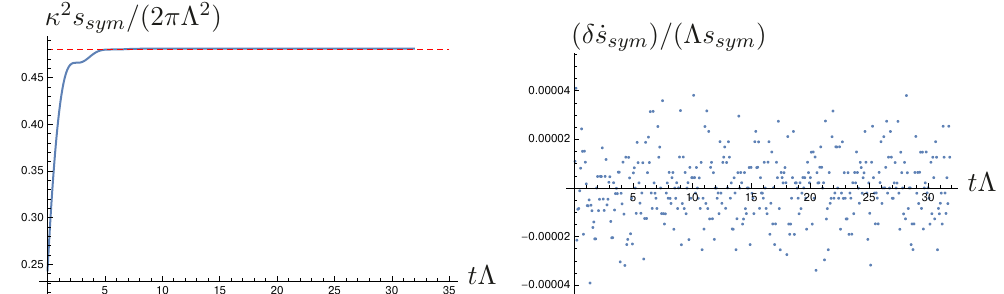
Figure 11 . Evolution of the entropy density in Z 2 symmetric sector of sBBL model. The red dashed line indicates the equilibrium value (left panel). The entropy production rate is always positive during the evolution, see (3.25). The right panel presents numerical error in computation of the entropy production rate, see (3.26).